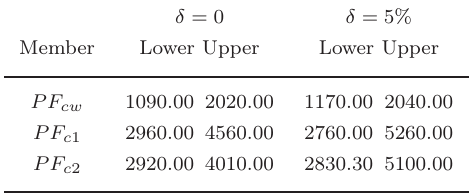
Table 3. Input data for lower and upper values of PF k ’s.